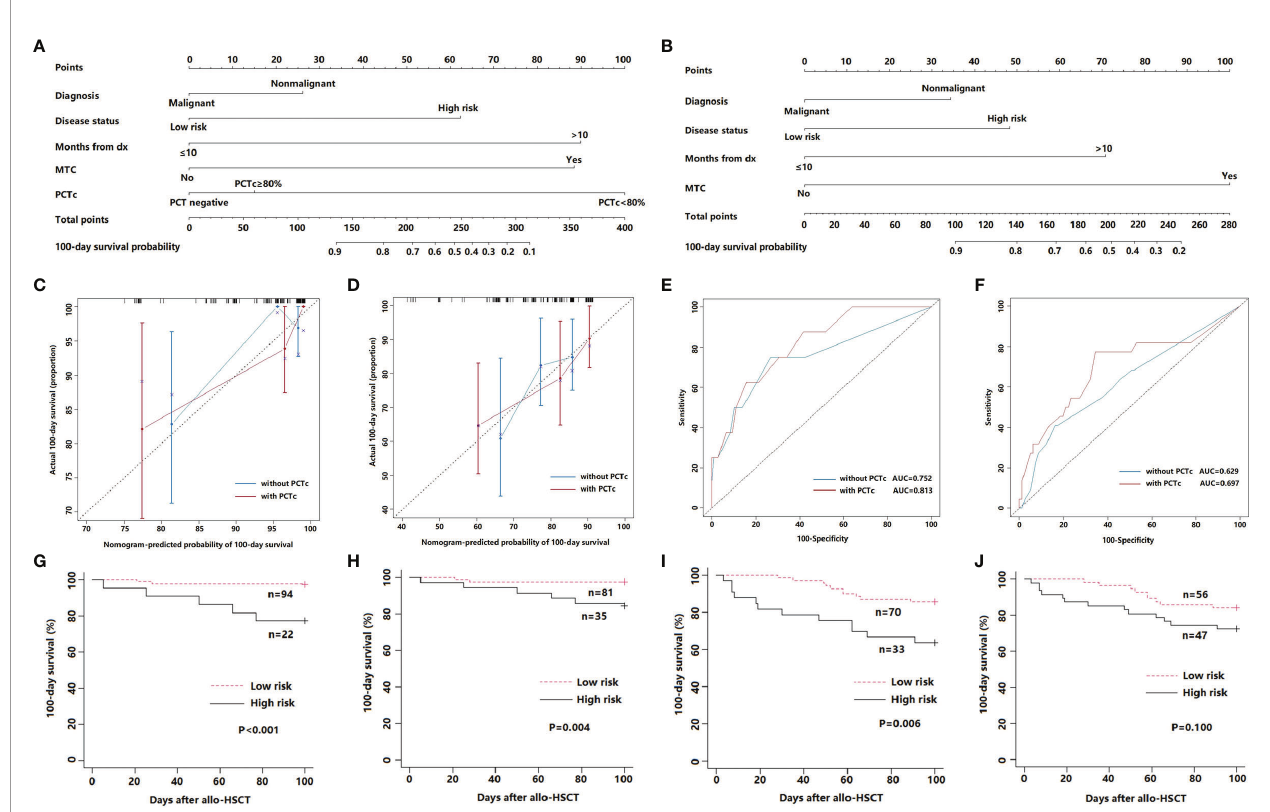
( Figure 4C ) and validation sets ( Figure 4D ). The C-indices of the nomogram were 0.808 and 0.691 for the primary and validation cohorts, respectively. The predicted model for 100- day survival probability had an AUC of 0.813 in the primary set